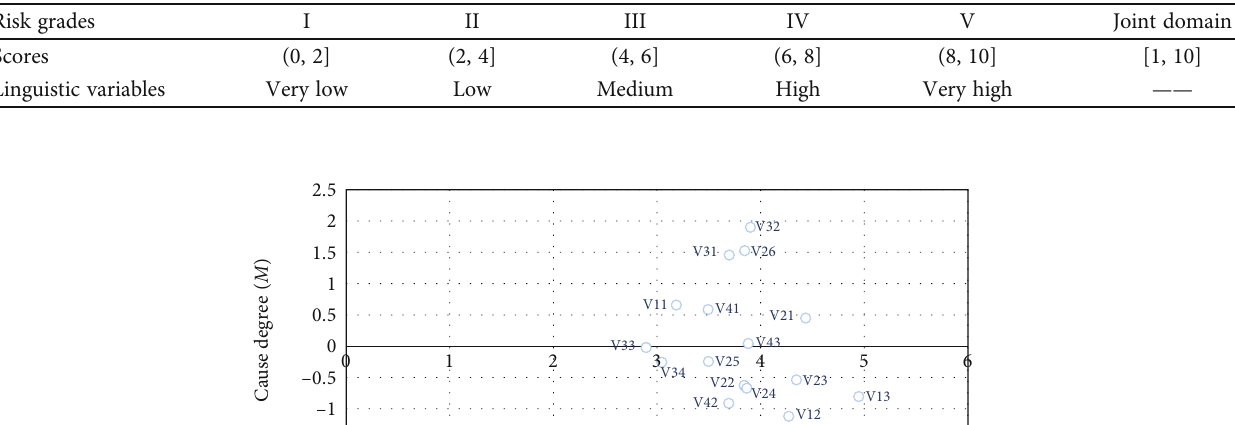
Table 5: Risk grades and corresponding scores for expert assessment.